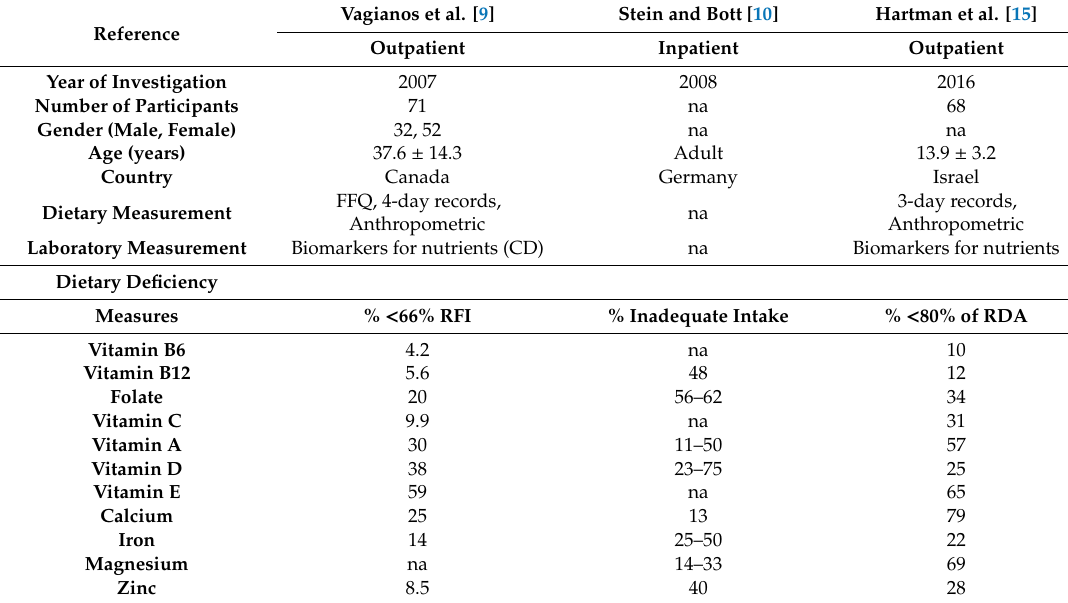
Table 1. Nutrient deficiencies in adults and adolescents with inflammatory bowel disease